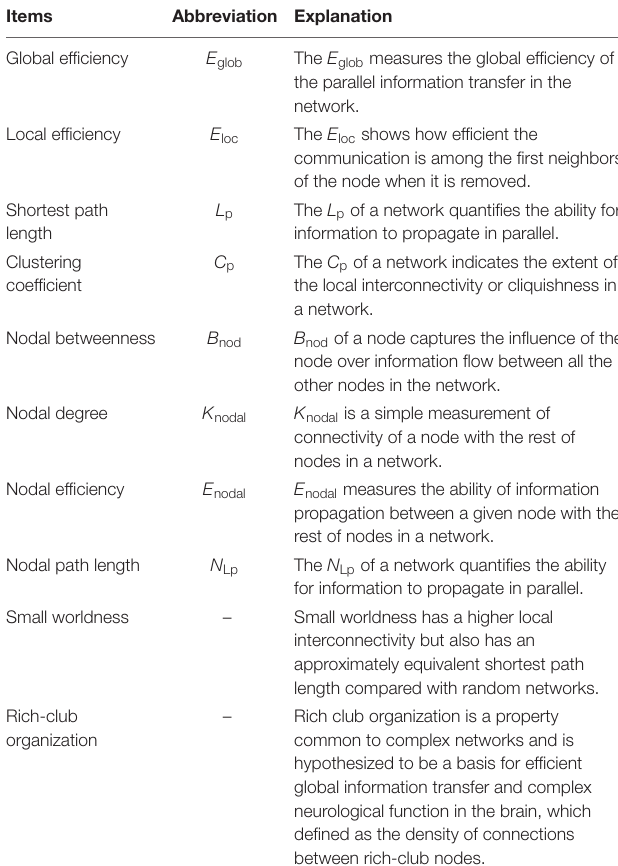
90 × 90 matrix ( Figure 1 ). Finally, we obtained the FA-weighted structural network for each participant from their DTI data, which was represented by a symmetric